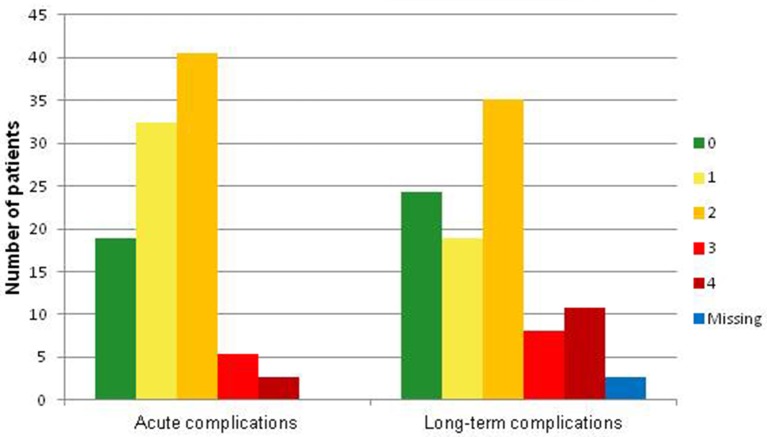
Frequency of medical complication.